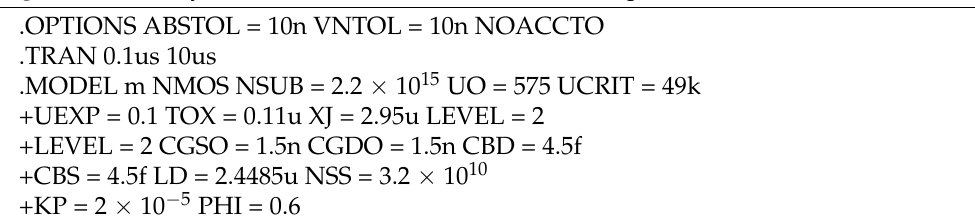
Algorithm 6 Analysis and Model Parameters of MOS